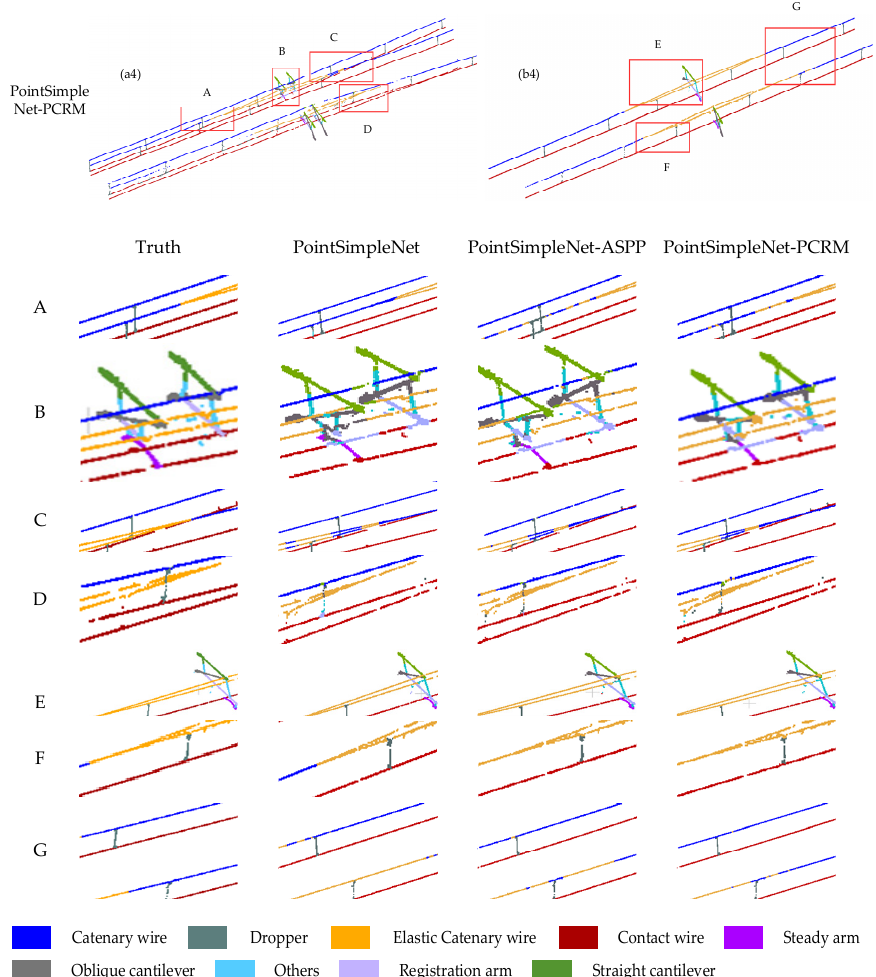
Figure 12. Comparison results of different refinement modules. Column ( a1–a4 ) and column ( b1–b4 ) are global images of double-armed and single-armed structures, respectively. The range delineated in the red box is enlarged to present a more detailed visual comparison at the bottom, where A, B, C, and D are the ROI in the double-arm scene, and E, F, and G are the ROI in the single-arm scene. Compared with the ASPP, the PCRM improved F1-Score, MIoU, and OA by 0.3%, 0.49%, and 0.94%, respectively. The fusion method of multi-layer features is changed